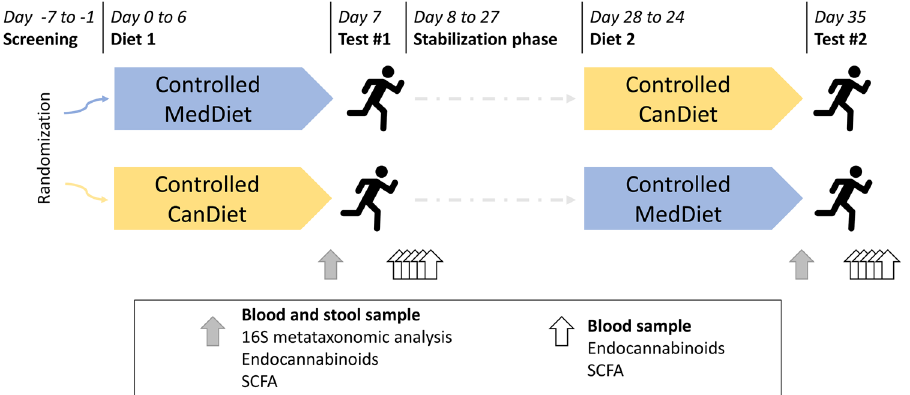
Figure 1. Schematic representation of the randomized crossover format of the study and the process from the start to the end including the periods of restricted diet, aerobic tests, samples taken and analyses